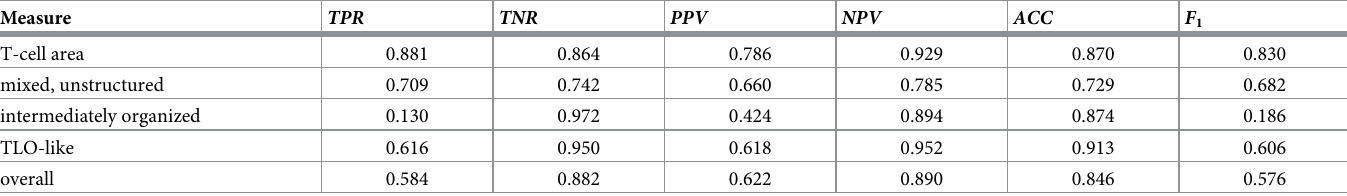
Table 1. Feasibility of support vector machine using 5-fold cross validation.